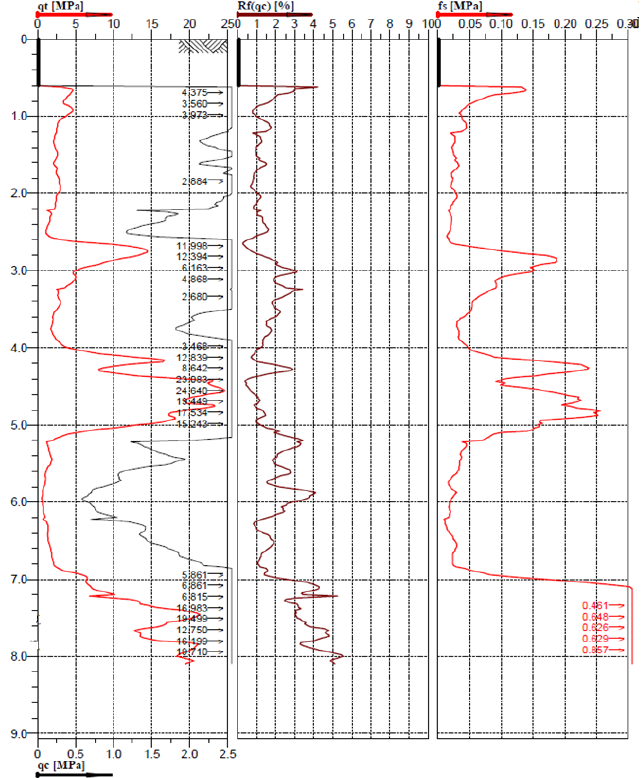
Figure 8. Results of the CPT sounding from the dumps at the sites of ash deposition [19].